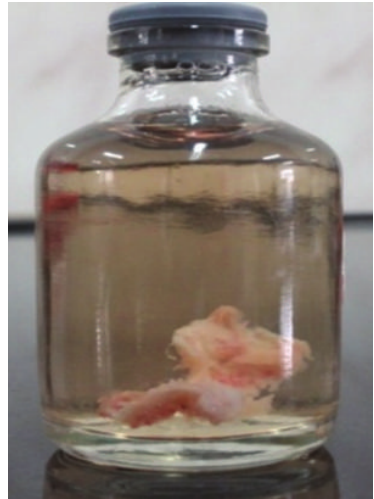
Figure 35: Flap retraction and exposure of the cyst.